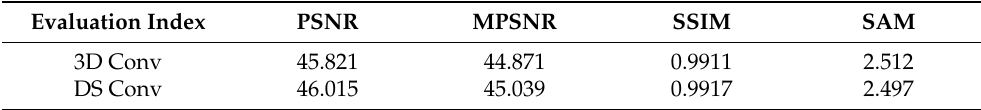
Table 6. Comparison of the network performance between the standard convolution and depthwise separable convolution under the cave dataset with a scale factor of